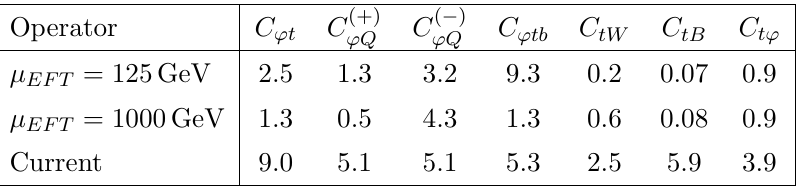
Table 13 . Sensitivity of Higgs measurements at HL-LHC to top-quark operators, compared with current constraints. Here sensitivity is de(cid:12)ned as one half of the size of interval of coe(cid:14)cient C i at 95% CL, assuming (cid:3) = 1 TeV, and all other operators coe(cid:14)cients are set to